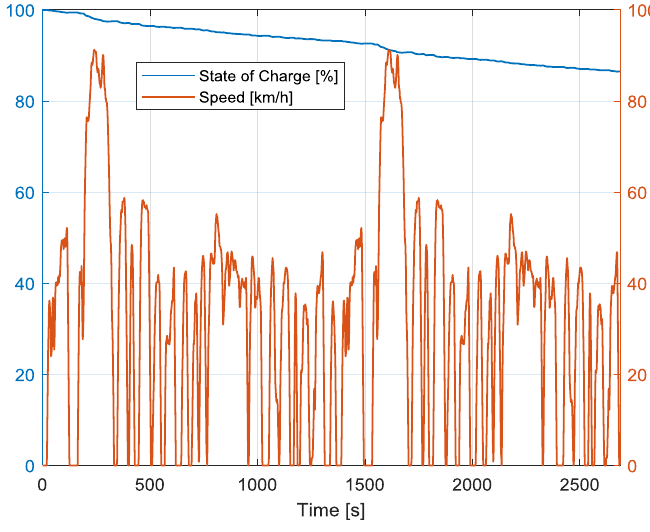
Figure 7. EPA LA4 driving cycle consumption estimation.